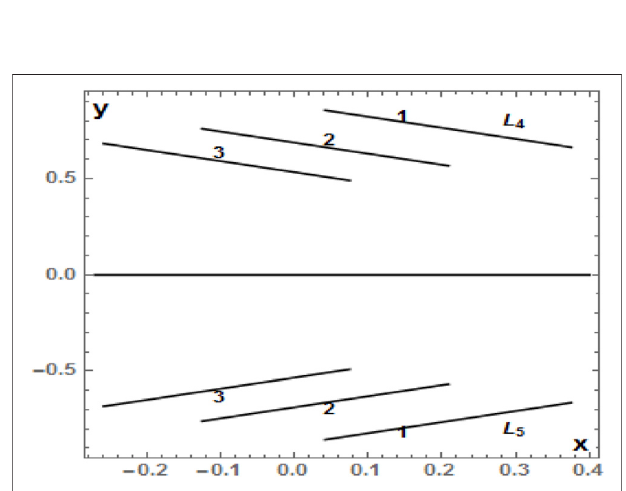
FIGURE 10 | Positions of the two triangular equilibrium points L 4 and L 5 on the xy – plane asa function of A 3 , which varies in the interval (0, 0.1) for fi xed valuesof M b equal to0.06 (1),0.1(2),and 0.15(3). Theradiation pressureand triaxiality parameters are kept as constants as in Table 7